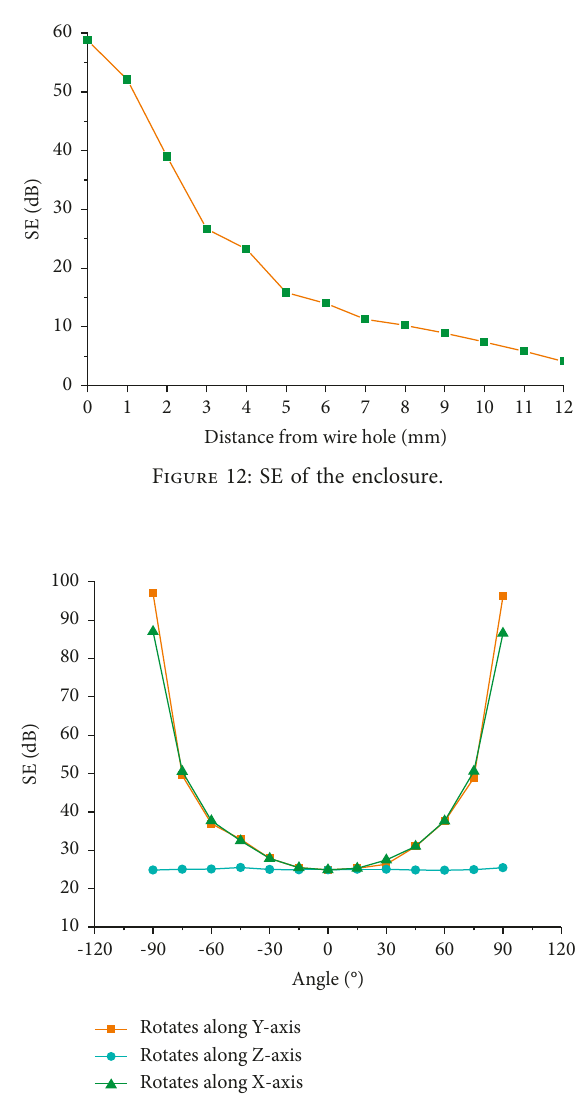
Figure 13: Influence of incidence angle on